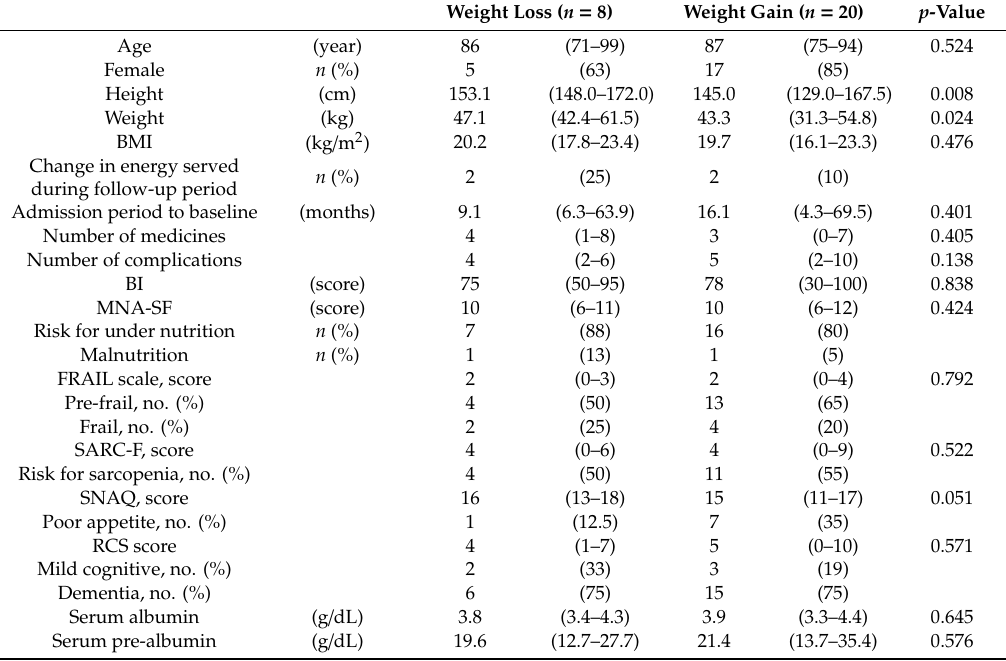
Table 2. Baseline characteristics and comparison between the weight loss and gain groups ( n =